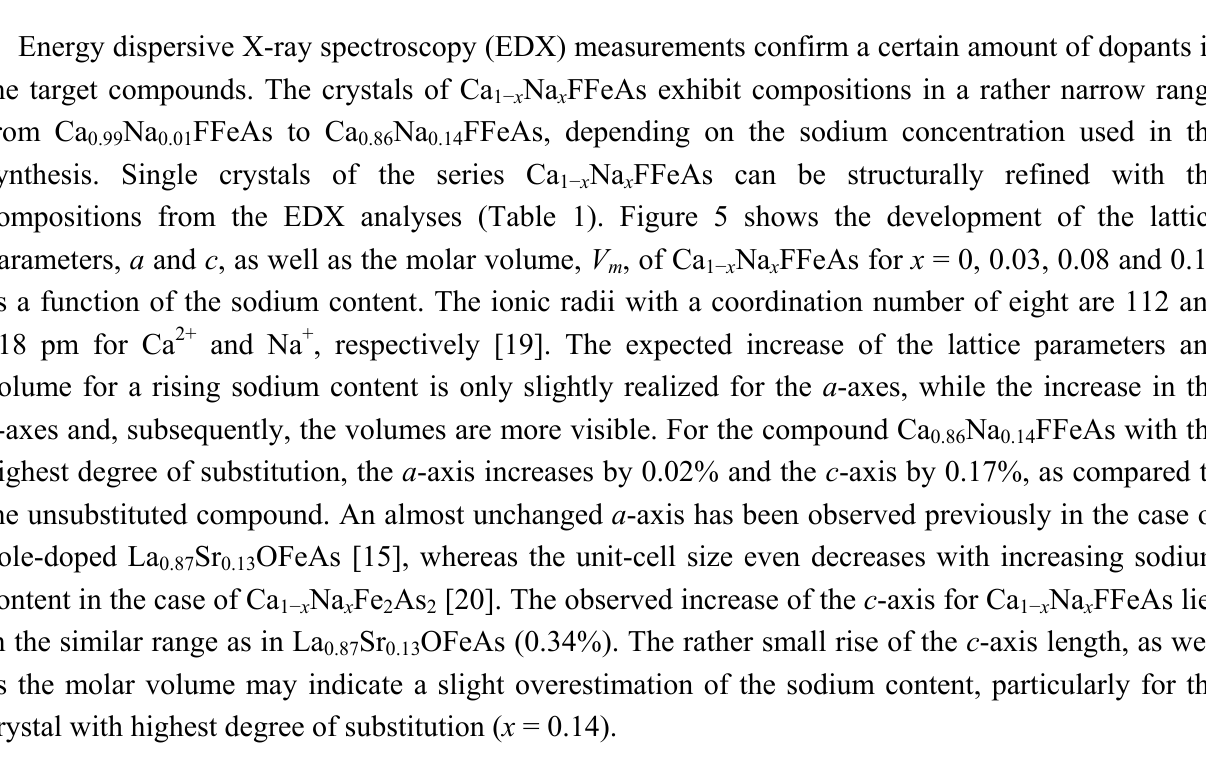
Na FFeAs phases versus the 1 − x x